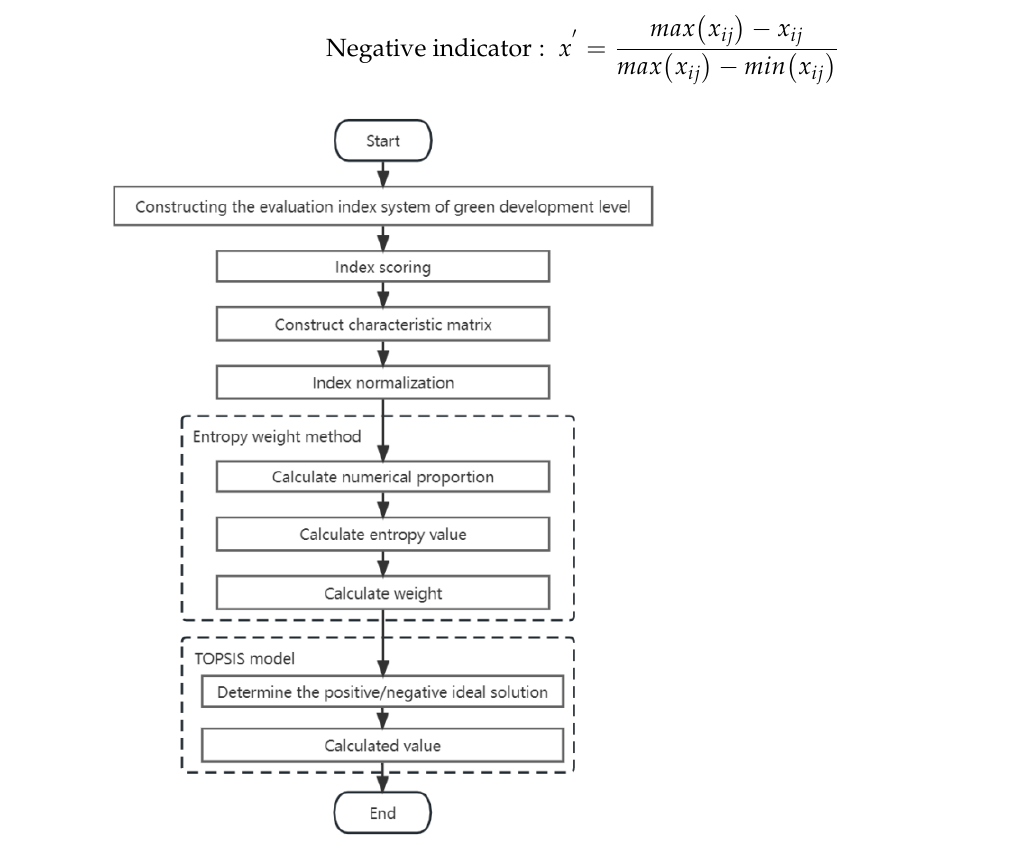
Figure 1. The calculation process of the entropy weight TOPSIS method. In Formulas (2) and (3), x ij represents the index data; max(x ij ) and min(x ij ) are the The specific calculation process is as follows. maximum and minimum values, respectively, in the index data. Second, the weight of each indicator is